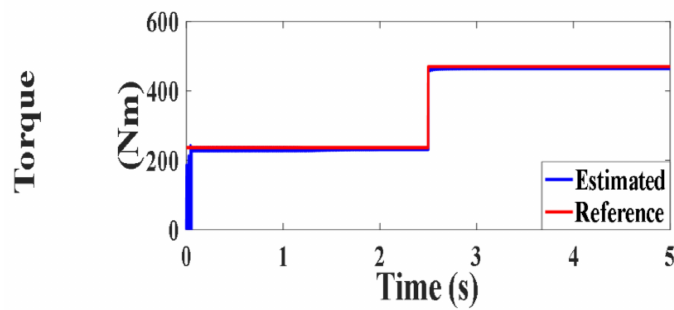
Figure 19. Developed torque under SVOC (Nm).